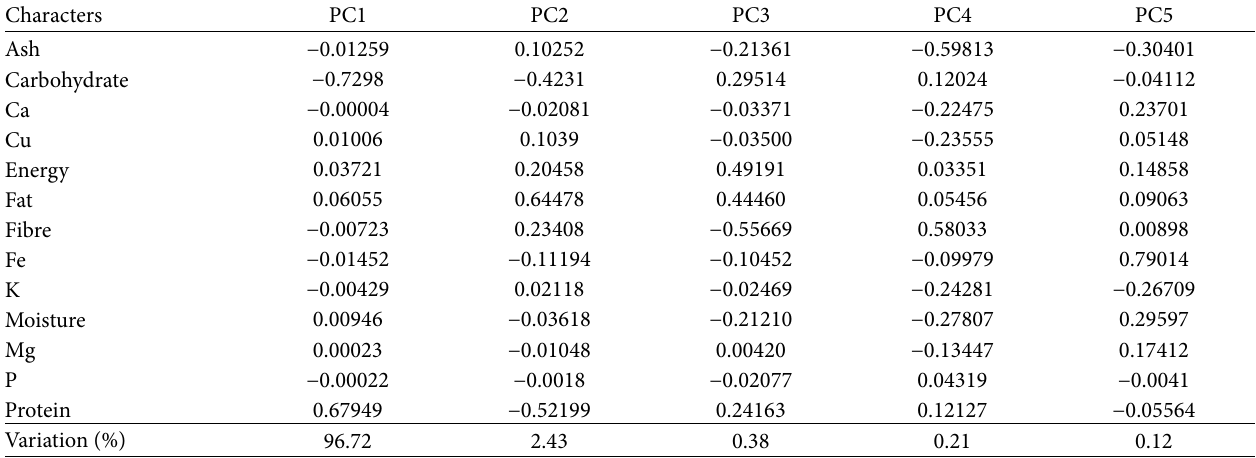
Table 4: Principal component analysis of the biochemical traits of the 18 taro genotypes.